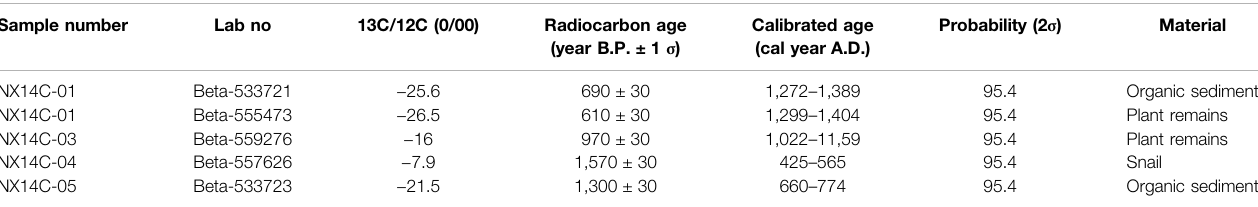
TABLE 1 | Radiocarbon analyses of